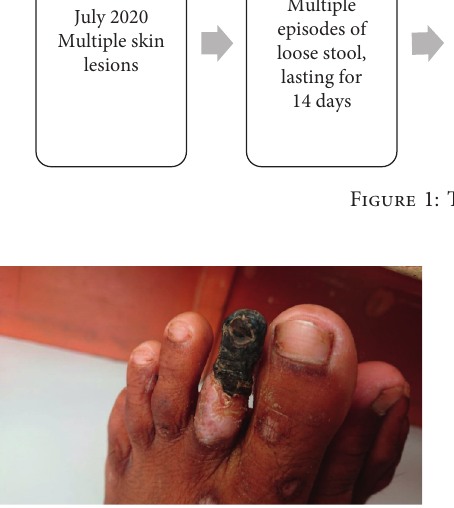
Figure 2: Dry gangrene in the left second toe.